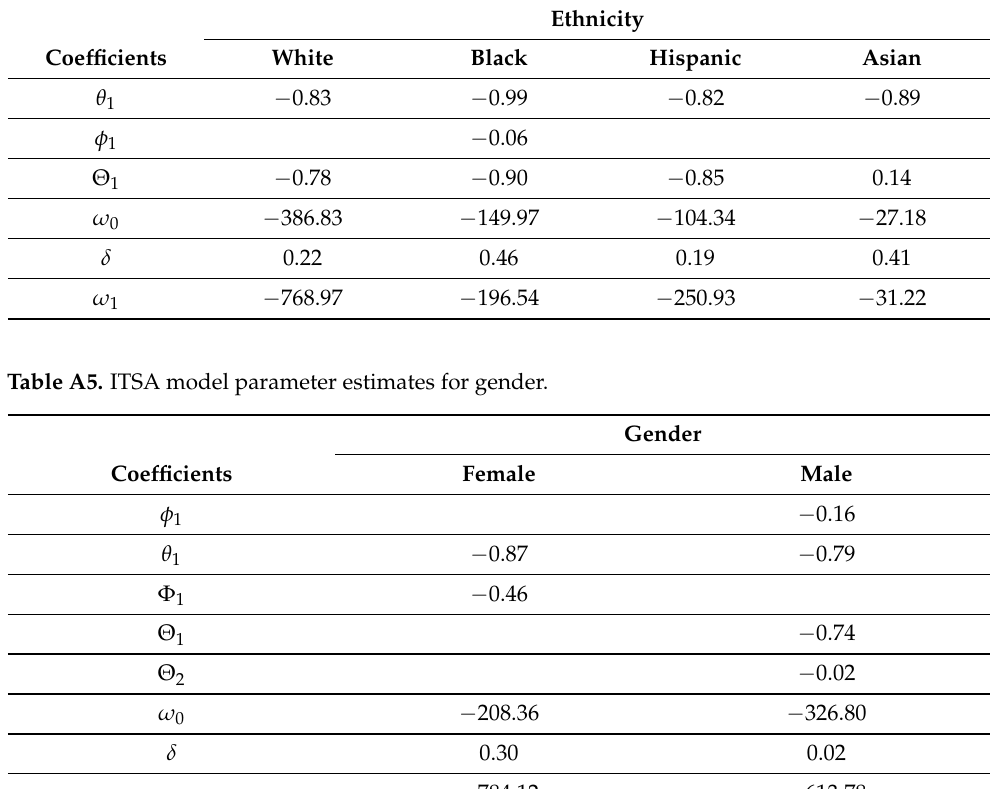
Table A4. ITSA model parameter estimates for ethnicity.